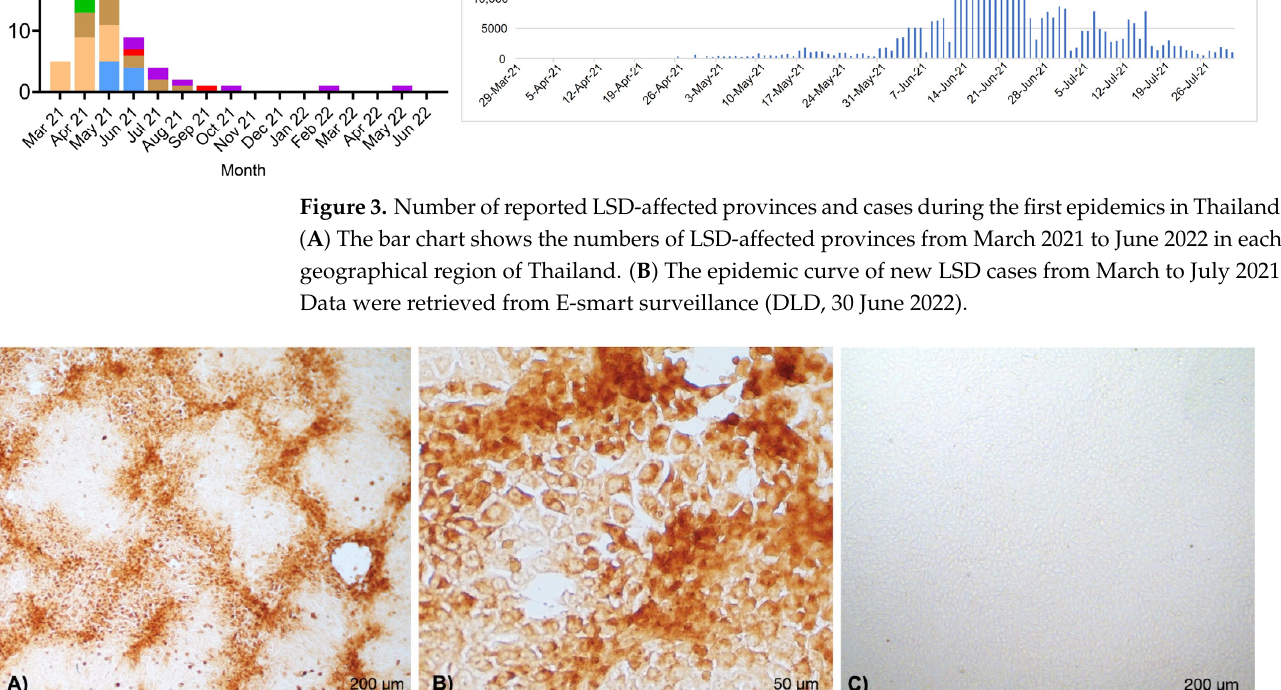
Figure 4. IPMA of LSDV infected MDBK cells. The cells were incubated with LSDV-specific antibodies in the convalescent bovine serum, followed by HRP conjugated bovine IgG, and stained with DAB substrate. LSDV infected cells contained brown staining LSDV antigens predominantly in the cytoplasm. Cytopathic effects (CPE) appeared as groups of aggregated LSDV infected cells ( A , B ). Non-infected cells remained unstained and served as a negative control ( C